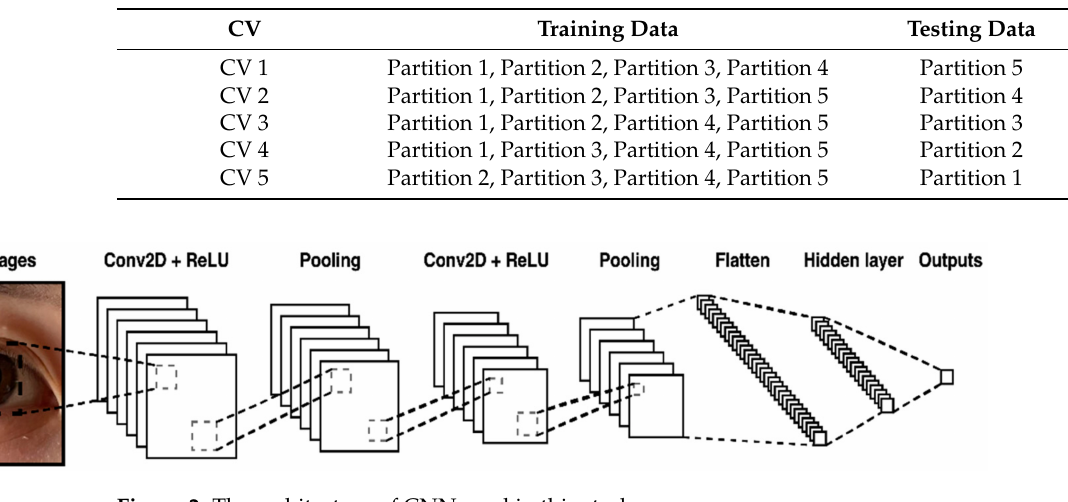
Table 2. The training data and testing data for dataset I with fivefold cross-validation.